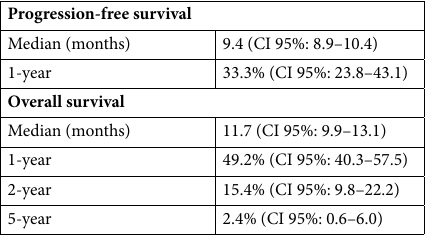
Table 3. Progression-free and overall survival outcomes (N = 128).